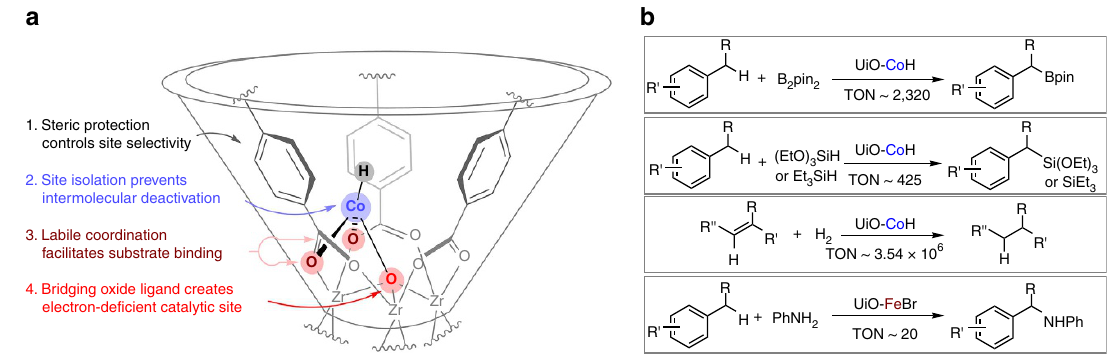
Figure 3 | Conceptual approach to designing Co@SBU single-site solid catalysts for chemoselective sp 3 C–H functionalization and other reactions. ( a ) An electron-deficient Co(II)-centre located in a unique sterically protected environment at the SBU of UiO-68 favours the activation of less-hindered alkyl C–H bonds over aryl C–H bonds via proposed s -bond metathesis pathways. ( b ) The sp 3 C–H functionalization reactions and alkene hydrogenation catalysed by M@SBU catalyst (M ¼ Co